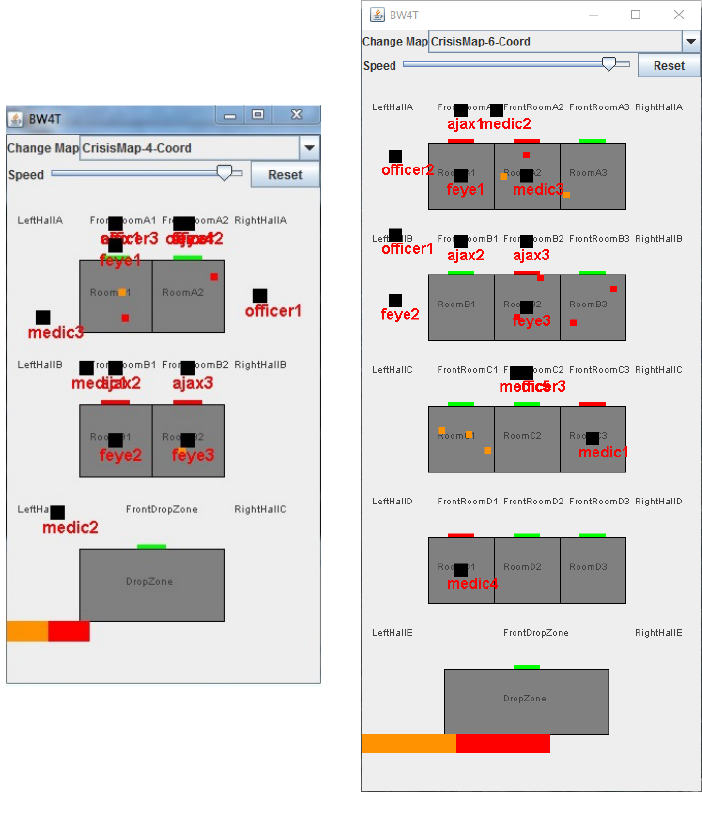
Figure 4. BW4T crisis